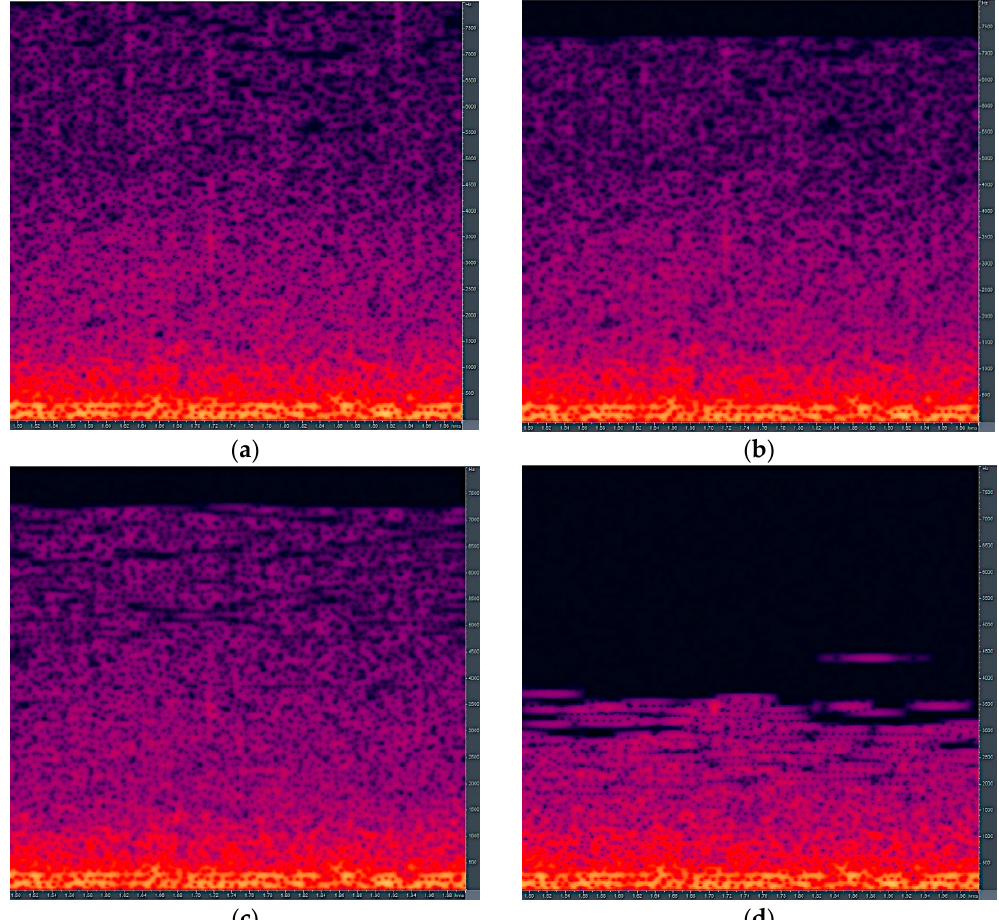
Figure 4. Spectral characteristics of the uncompressed bee audio signal ( a ) and MP3 encoded audio with 64 kbps ( b ), 32 kbps ( c ), and 16 kbps ( d ) bitrates. The X-axis denotes time in seconds and Y-axis denotes frequency in Hz. The amplitude is given by color, where dark represents low amplitude and bright yellow represents high amplitude.